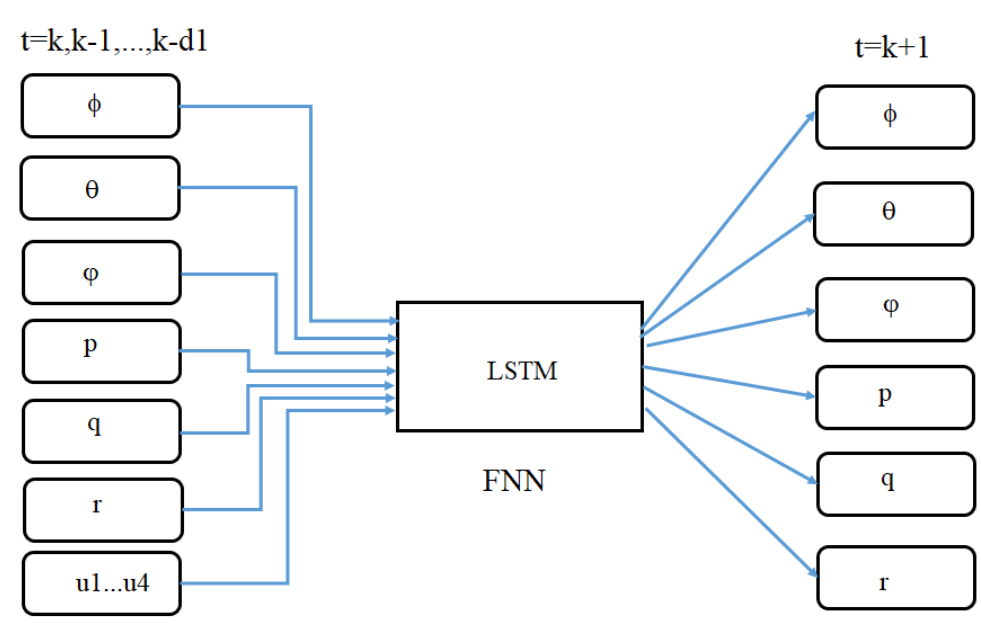
Figure 4. Modelling diagram of LSTM